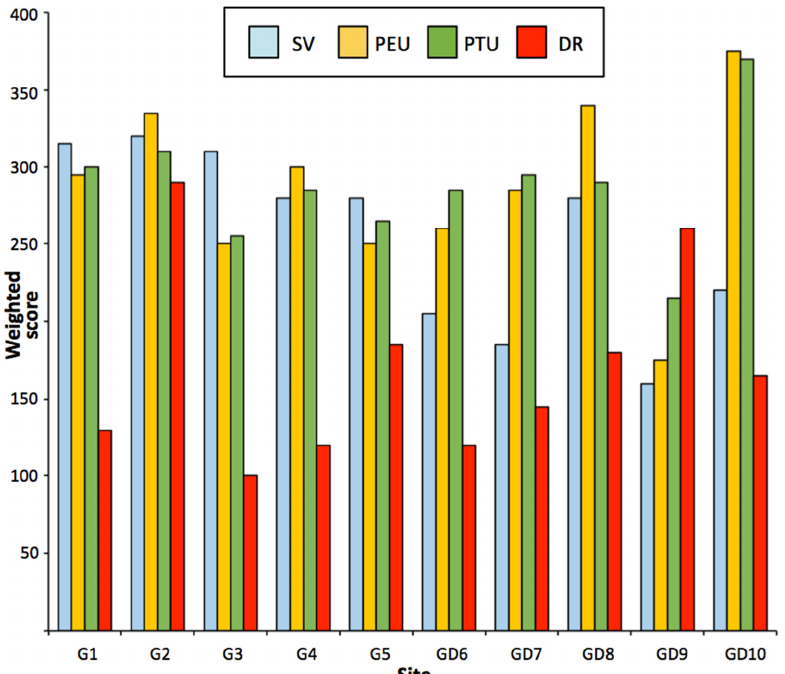
Figure 5. Weighted scores for the selected geosites. SV: scientific value; PEU: potential educational use; PTU: potential touristic use; DR: degradation risk. The description of the sites is reported in Tables 1 and 2. The tables with the results of the quantitative assessment and the weighted scores are reported in supplementary material (Tables S1 and S2, respectively). Geosites that are not on the ISPRA inventory (Table 2) have significantly lower scores for SV (160–220), except for Site GD8 (“Laione peat bog”; 280). This site (GD8) should be